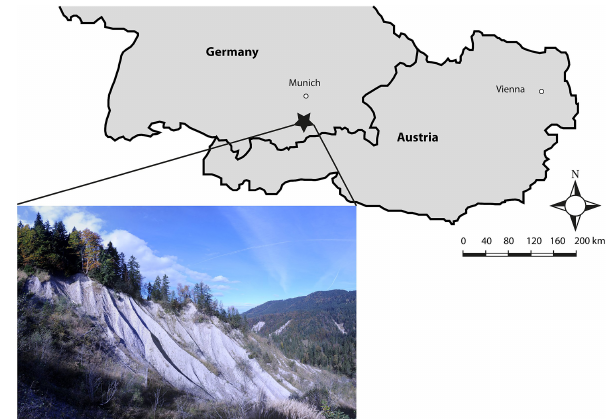
Figure 1. The study area is located in the Lainbach valley catch- ment in the Northern Bavarian Alps,